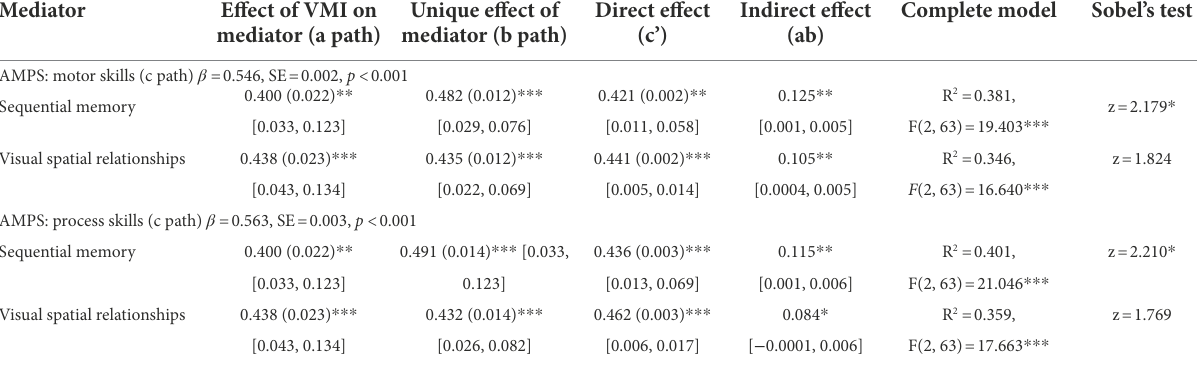
TABLE 3 Regression for mediation analysis.